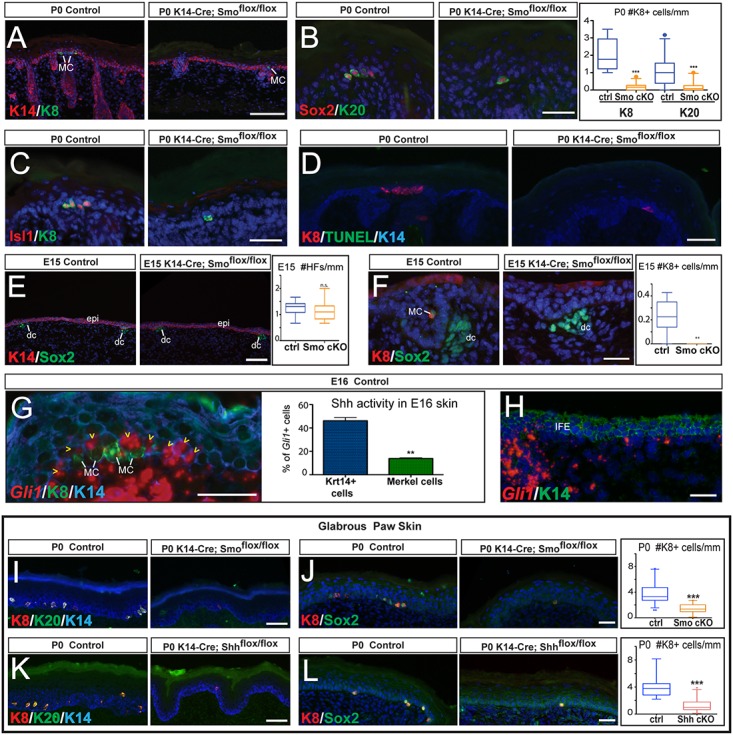
Shh signaling activity in the epidermis is required for Merkel cell formation.(A-C) IF stainings for Merkel cell markers Krt8 (K8) (A,C), Krt20 (K20) (B), Sox2 (B), and Isl1 (C) show a highly significant reduction in the number of Merkel cells in P0 Smoothened epidermis-conditional knockout (Smo cKO) (K14-Cre; Smoflox/flox) mice when compared to control (ctrl). Quantification of Krt8(+) and Krt20(+) Merkel cells in control and Smo cKO P0 skin (right panel of B) (both p<0.0001). (D) TUNEL staining shows no increase in apoptosis in the skin of P0 Smo cKO mice. Note that cells undergoing cornification are TUNEL(+) as previously reported [33]. (E) At E15, specification of hair follicles is not affected in P0 Smo cKO mice when compared with control. The number of hair follicles is quantified in the right panel (p = 0.3140). IF staining for Krt14 (K14) labels the epidermis (epi) and Sox2 labels the dermal condensate (dc) of the developing hair follicles in E15 WT and Smo cKO mice. (F) IF staining for Merkel cell markers Krt8 and Sox2 shows a complete absence of Merkel cells in E15 Smo cKO compared to control. The number of Krt8(+) Merkel cells is quantified in the right panel (p = 0.0018). (G) IF stainings for Merkel cell markers Krt8 and in situ hybridization for Gli1 RNA in E16 WT skin indicates that Gli1 is expressed in about 45% of the Krt14(+) (K14) cells (yellow arrowheads) surrounding the Merkel cells and in about 13% of early Merkel cells present in the skin at this time point, quantified in the right panel (p = 0.0022). (H) In situ hybridization for Gli1 RNA in E16 WT back skin indicates that Gli1 is not expressed in most Krt14(+) cells of the interfollicular epidermis (IFE). (I,J) IF stainings for Merkel cell markers Krt8 (I,J), Krt20 (I), and Sox2 (J) show that significantly fewer Merkel cells are present in the glabrous paw skin of Smo cKO mice compared to control paws. Quantification of Krt8(+) Merkel cells in paws (right panel of J) (p<0.0001). (K,L) IF stainings for Merkel cell markers Krt8 (K,L), Krt20 (K), and Sox2 (L) show that significantly fewer Merkel cells are present in the glabrous paw skin of Shh cKO mice compared to control paws. Quantification of Krt8(+) Merkel cells in paws (right panel of L) (p<0.0001). Unless otherwise indicated, all epidermis represented is dorsal skin. Scale bars: (A,E): 100μm; (B-D,F-L): 25 μm.